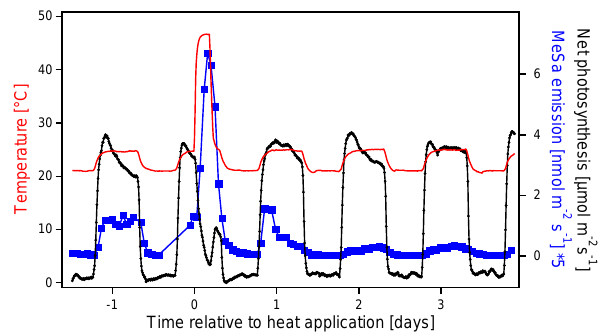
Fig. 7. Temporal shape of temperatures applied to Scots pine in ex- periment No. 6 (red line, left-hand scale), rates of net photosynthe- sis (black circles, right-hand scale), and MeSa emission rates (blue squares, right-hand scale, multiplied by 5 for clarity). Rates of net photosynthesis were suppressed for few hours only after the high temperature stress, but MeSa emissions dropped to about 1/5 the day after thermal stress